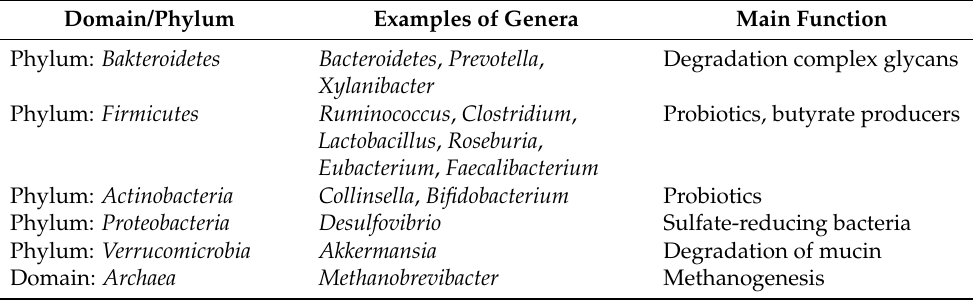
Table 1. The main representatives of intestinal bacteria